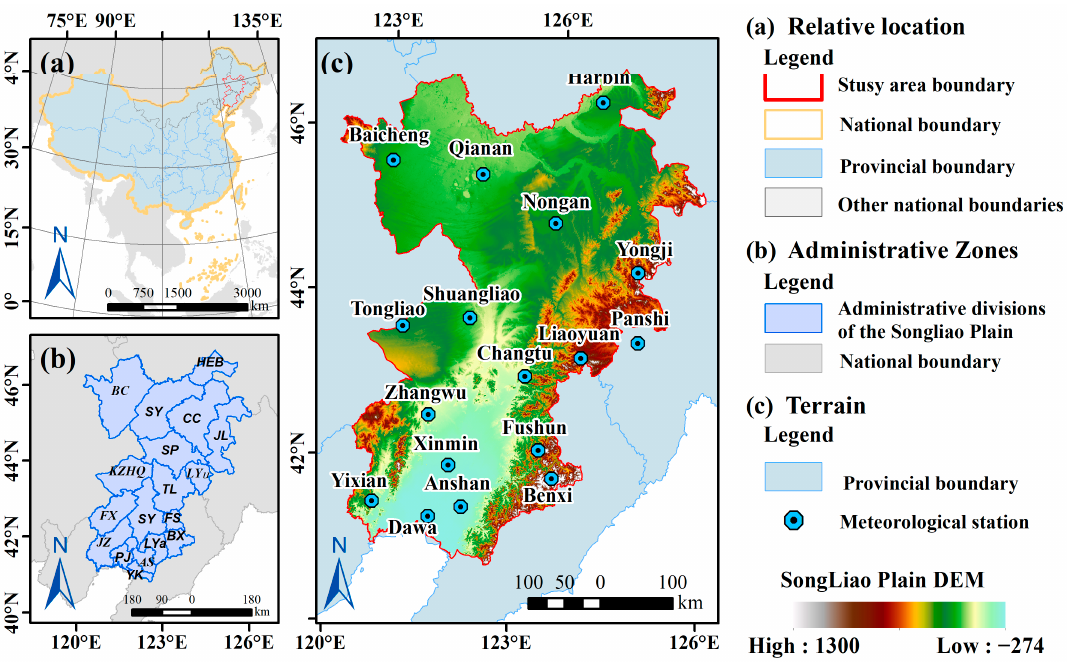
Figure 1. ( a ) Location map of the study area; ( b ) the administrative divisions of its district; and ( c ) its DEM.